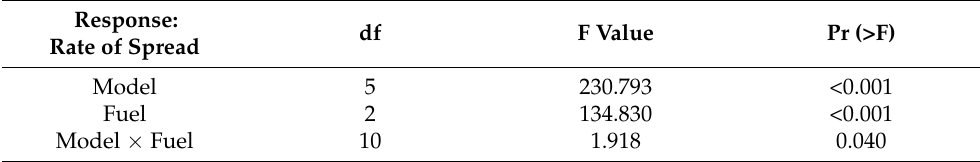
Table 4. ANOVA comparing the effects of fire behaviour model (Model), fuel class (Low, Medium, or High load), and their interaction on rate of spread predictions for the broader range of fire weather conditions. ‘df’ is n − 1 degrees of freedom. ‘F Value’ is the test statistic computed. ‘Pr (>F)’ is a significance value for each test set against α = 0.05. N =